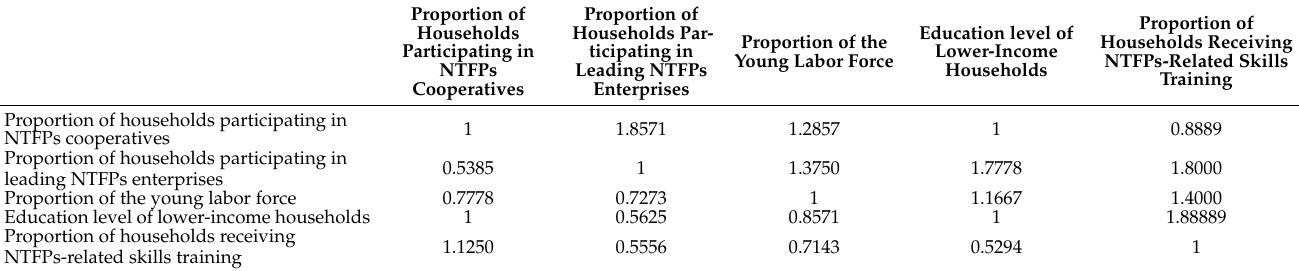
Table A8. C4–D: Judgement matrix of the sustainability of income increase.